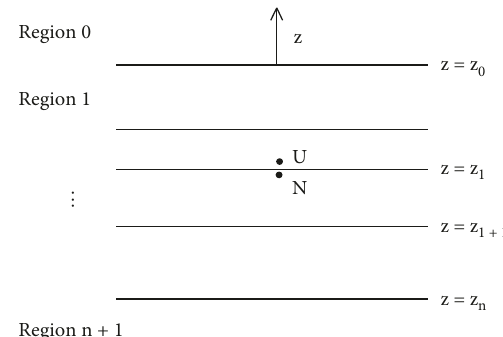
Figure 5: Layered anisotropic medium.